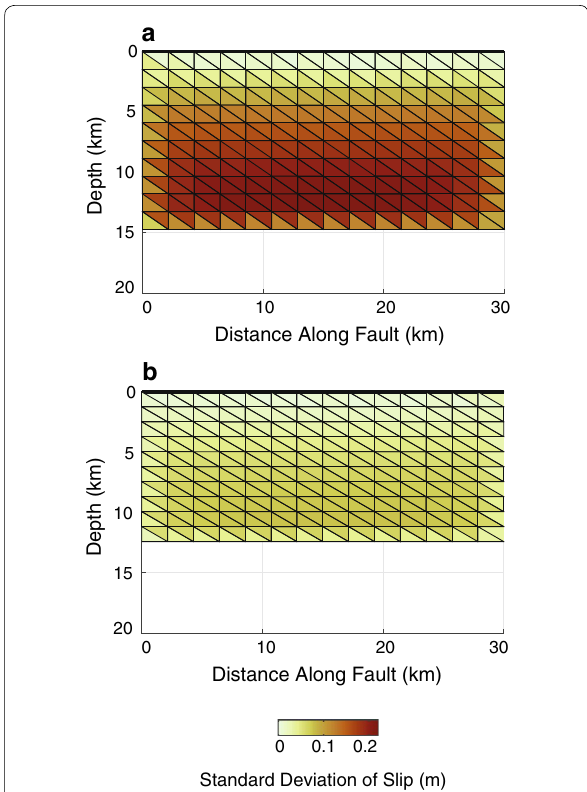
Fig. 7 Estimated standard deviation of slip on the fault elements: a NE-dipping fault model; b south-dipping fault